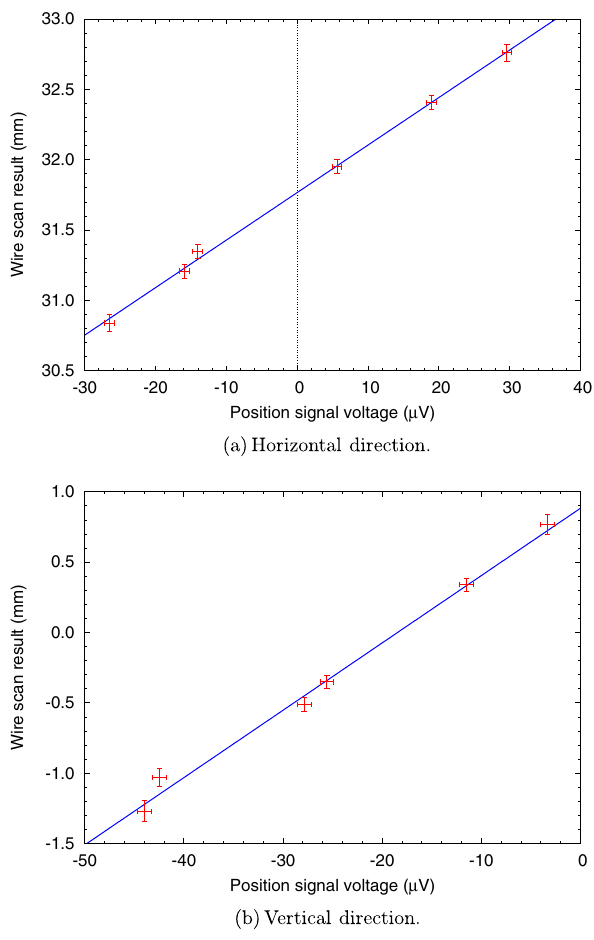
FIG. 9. Calibration of the position measurement by comparing the signal voltages with wire scan results, performed at a beam current of 800